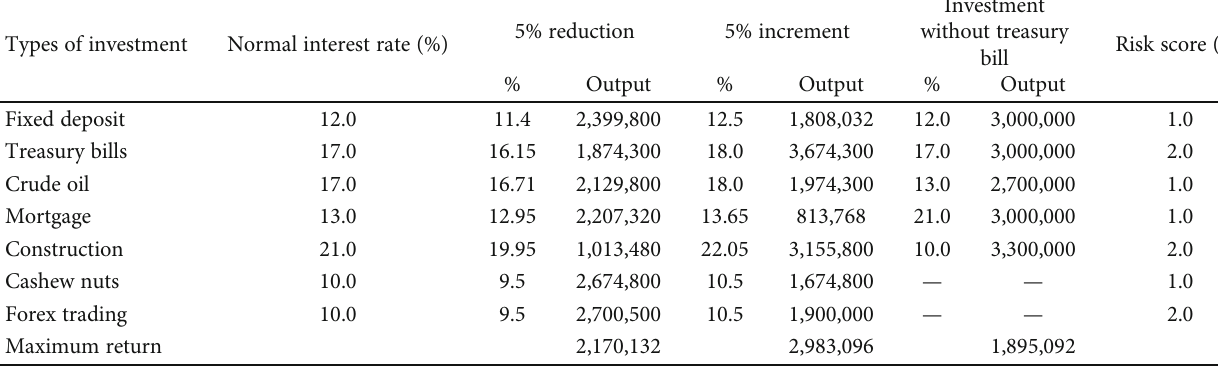
Table 3: The sensitivity analysis results of the portfolios in linear programming.